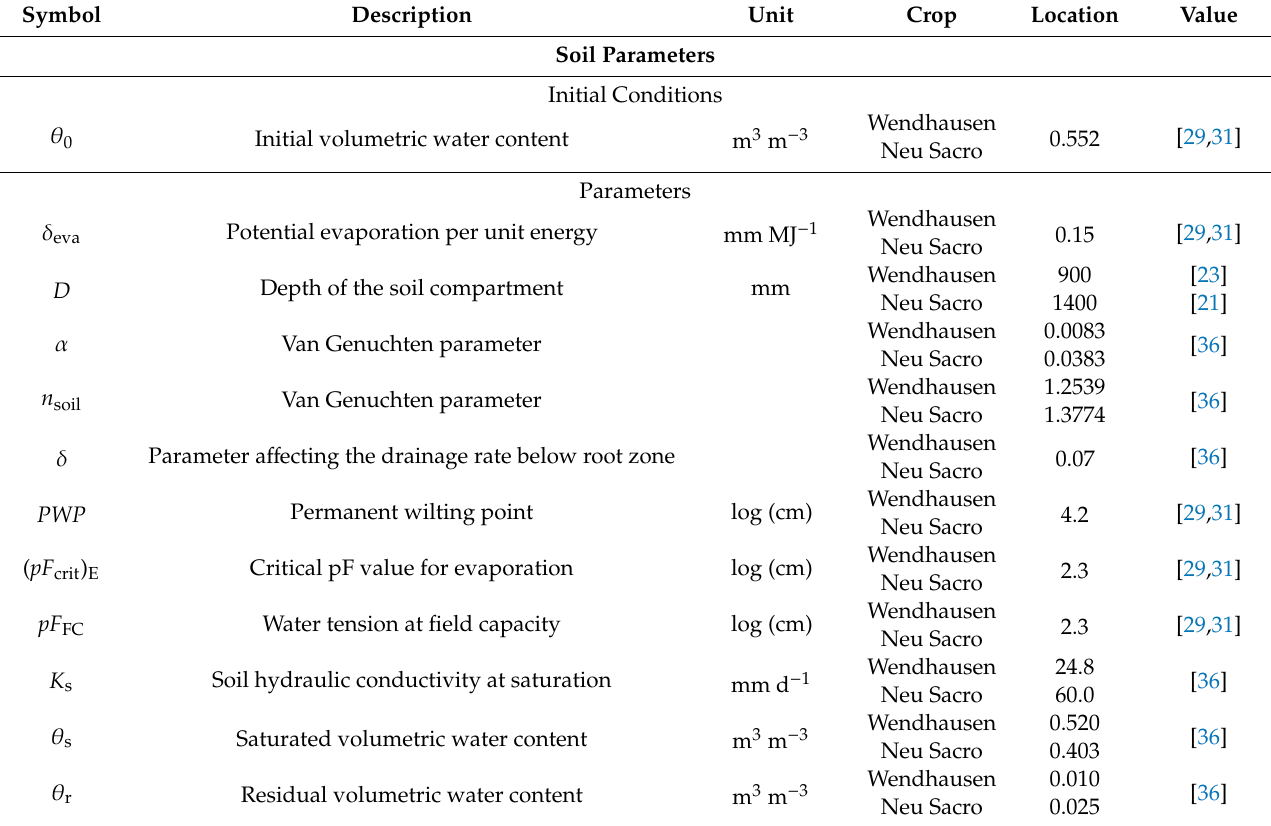
Table A3. Soil parameter values used for the parametrization of the Yield-SAFE